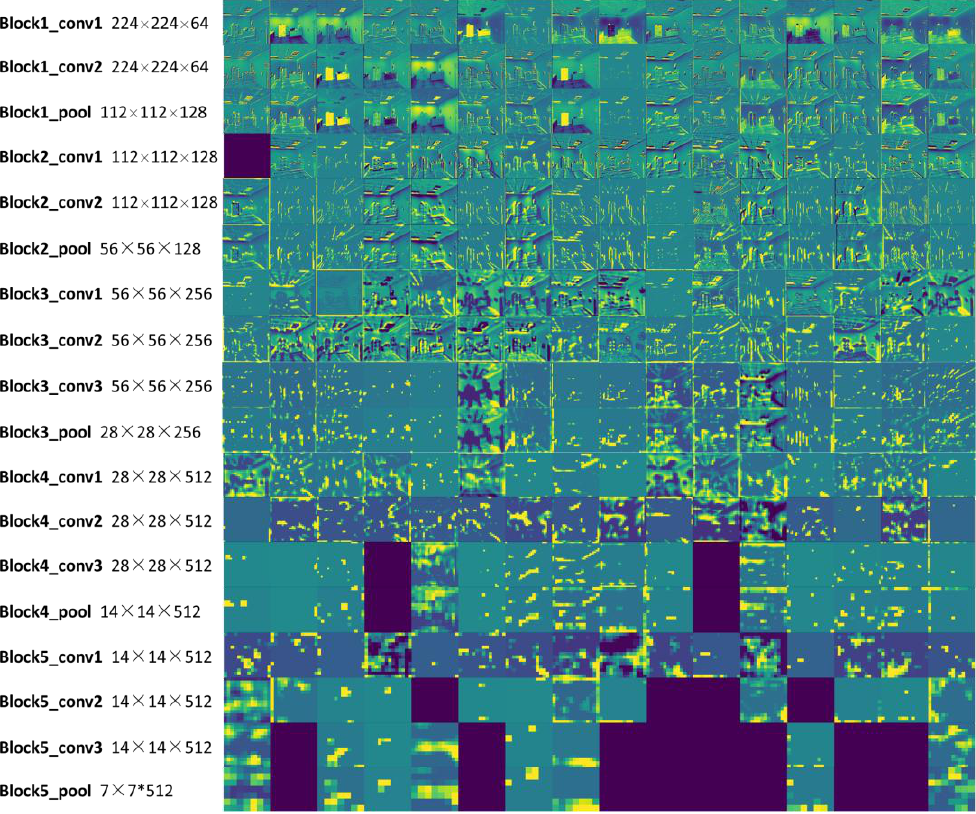
Figure 3. Convolution layers visualization. The first 16 matrices of each layer were visualized, and empty matrices corresponding to dropped out part in CNN. In order to better visualize features in layers, a viridis color map was employed, so layer maps looked greenish.